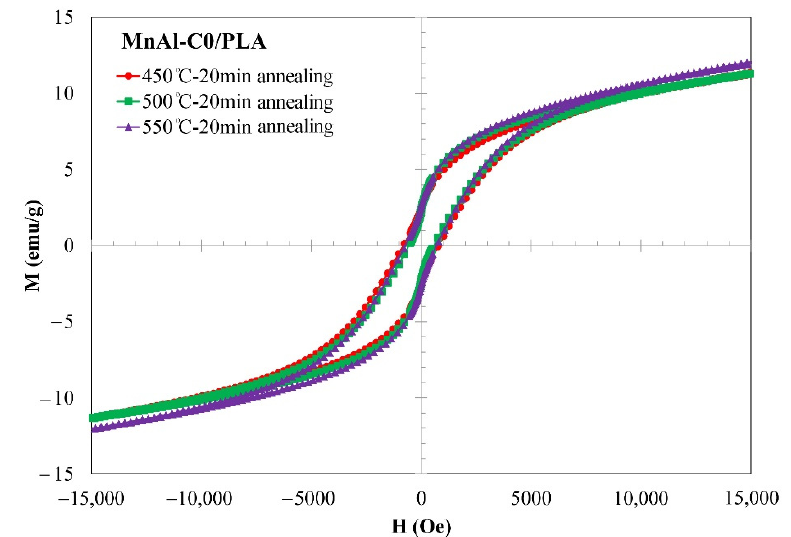
Figure 8. Hysteresis loops of MnAl-C0/PLA prepared from magnetic powders and annealed at 450, 500, and 550 °C for 20 min under argon atmosphere.